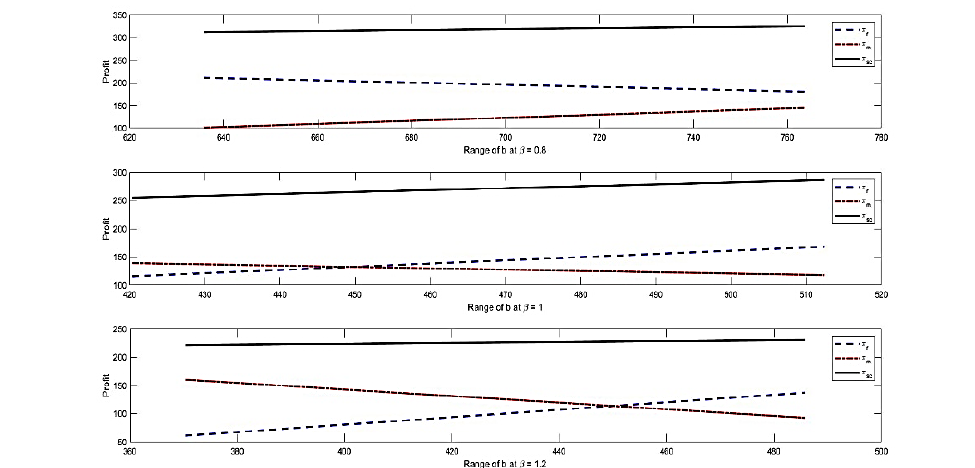
Fig. 11. The trend of variations in firms' profits due to variations in parameter β after signing the